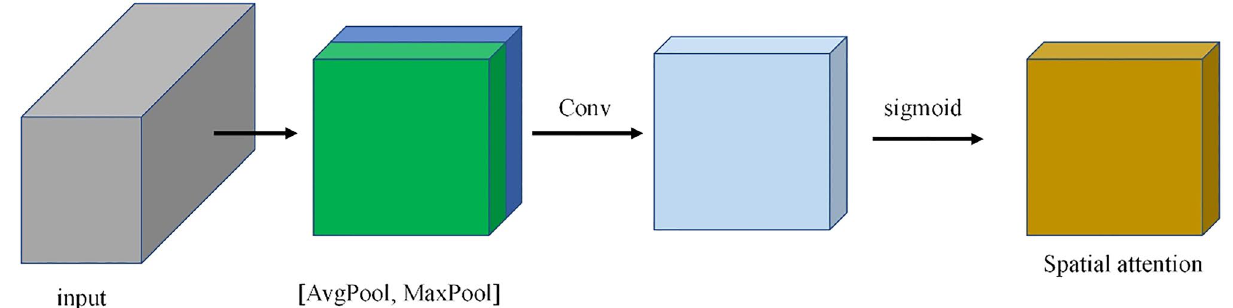
Figure 5. Generate spatial attention. This module concatenates the outputs of global average pooling and global max pooling through a convolutional